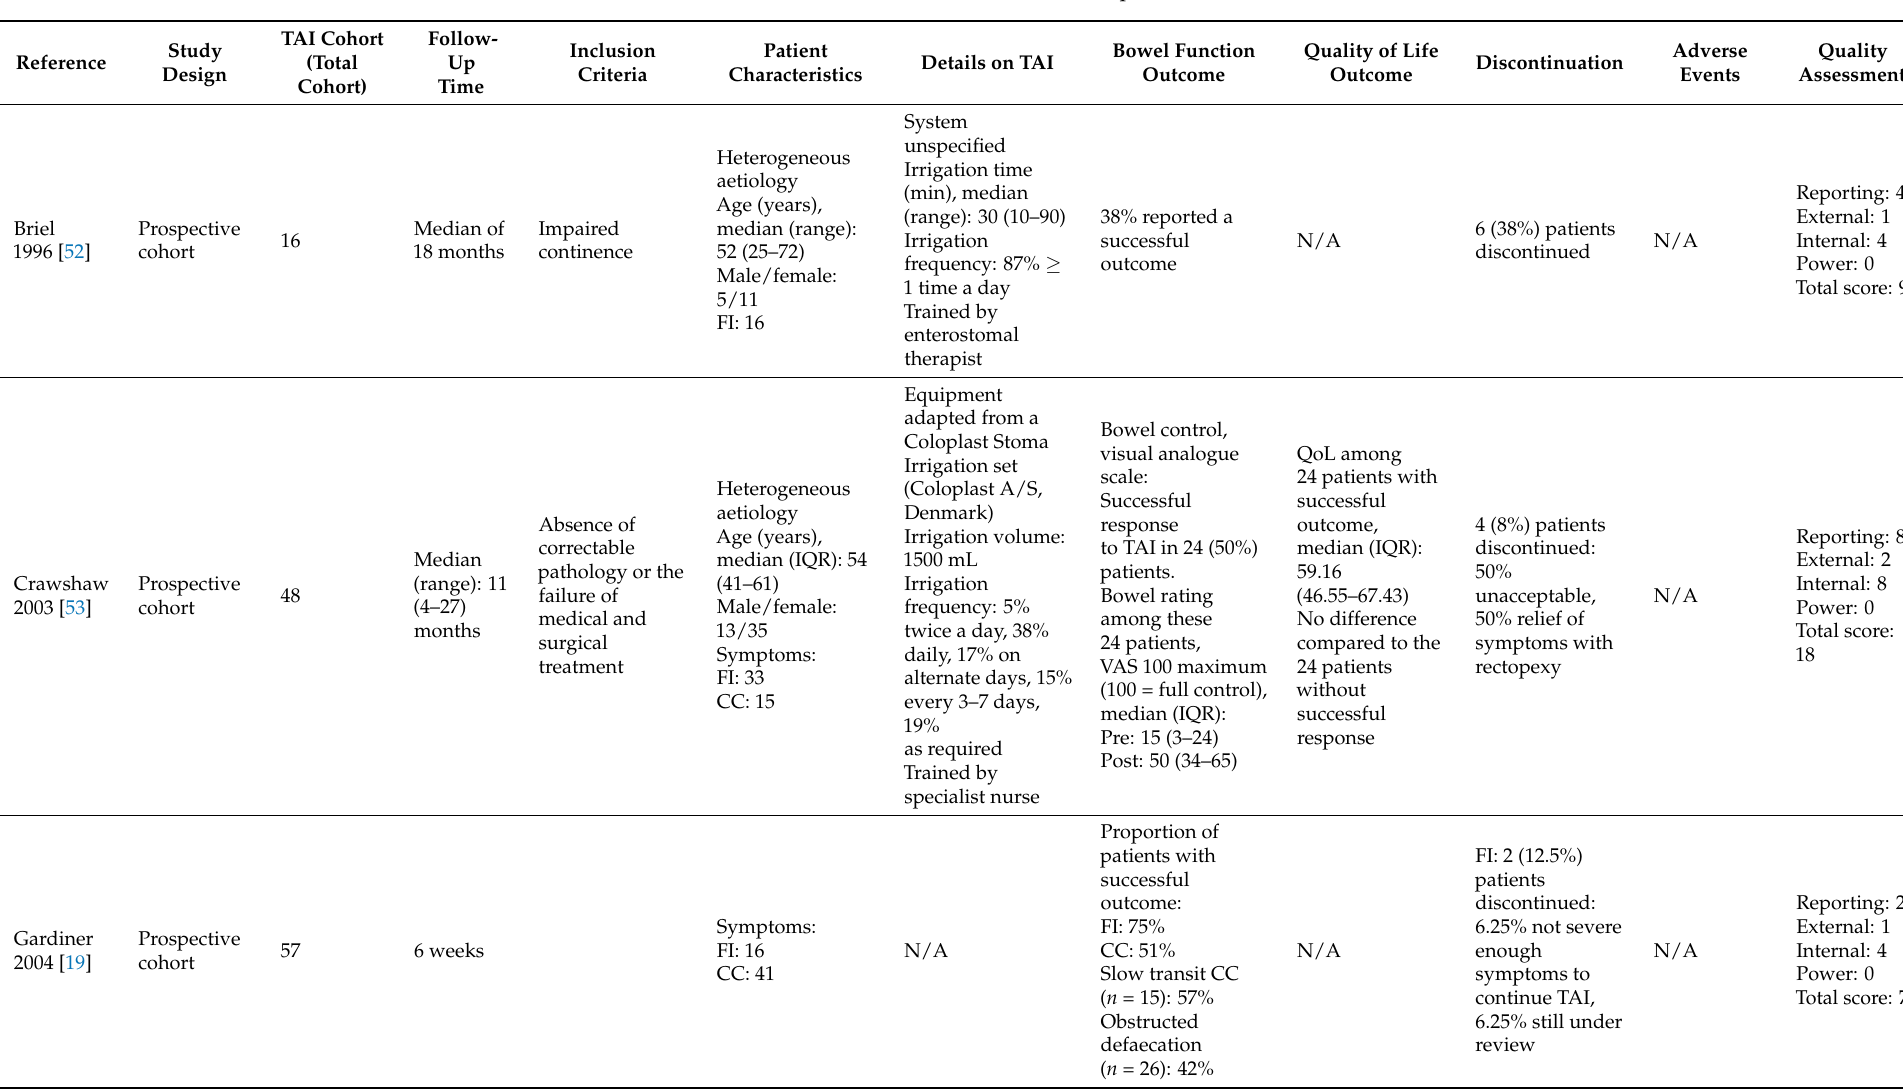
Table 3. Faecal incontinence and